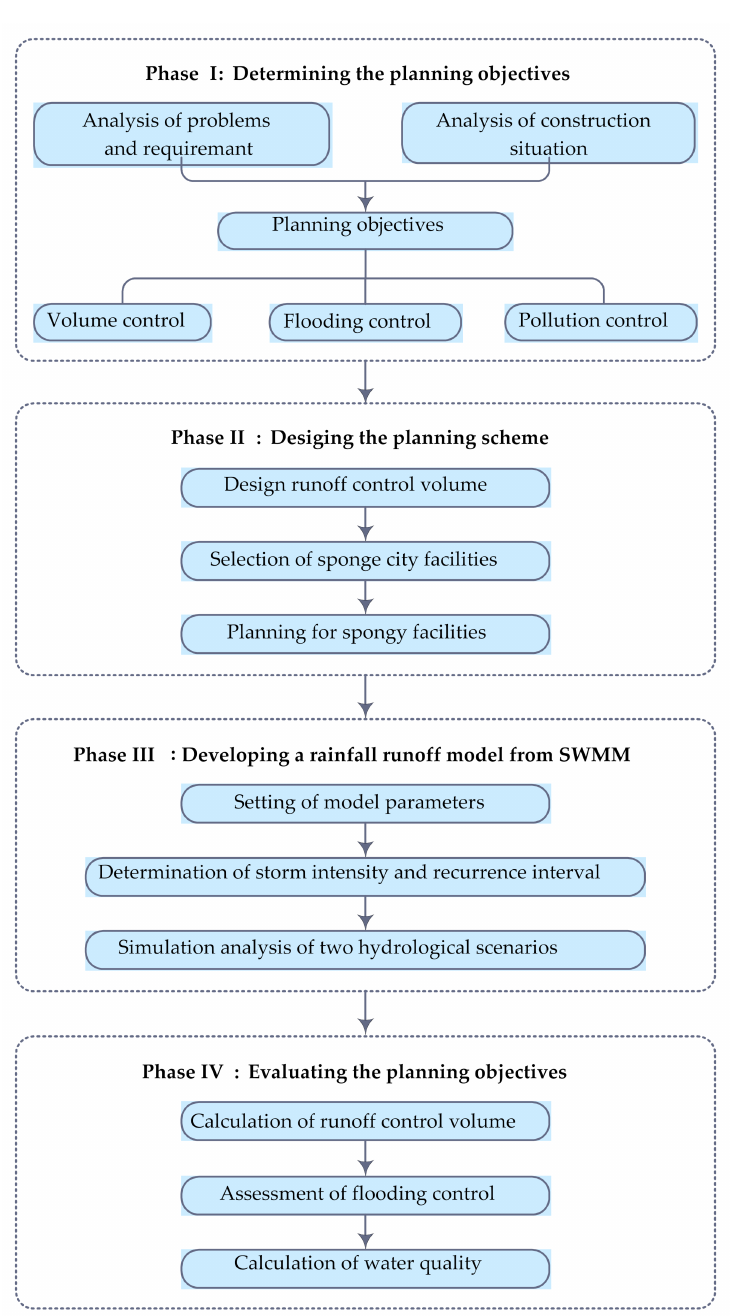
Figure 3. Flowchart of the stormwater management based on Low Impact Development (LID) in an old residential